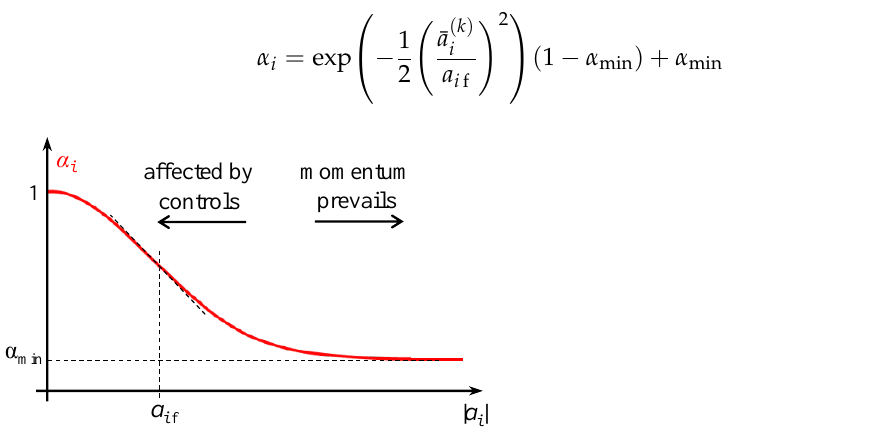
Figure A5. Weight function for averaging EKF state estimations and AM4 predictions; v i f is the flipping velocity, v i max is the maximum expected speed, and α min is a calibration